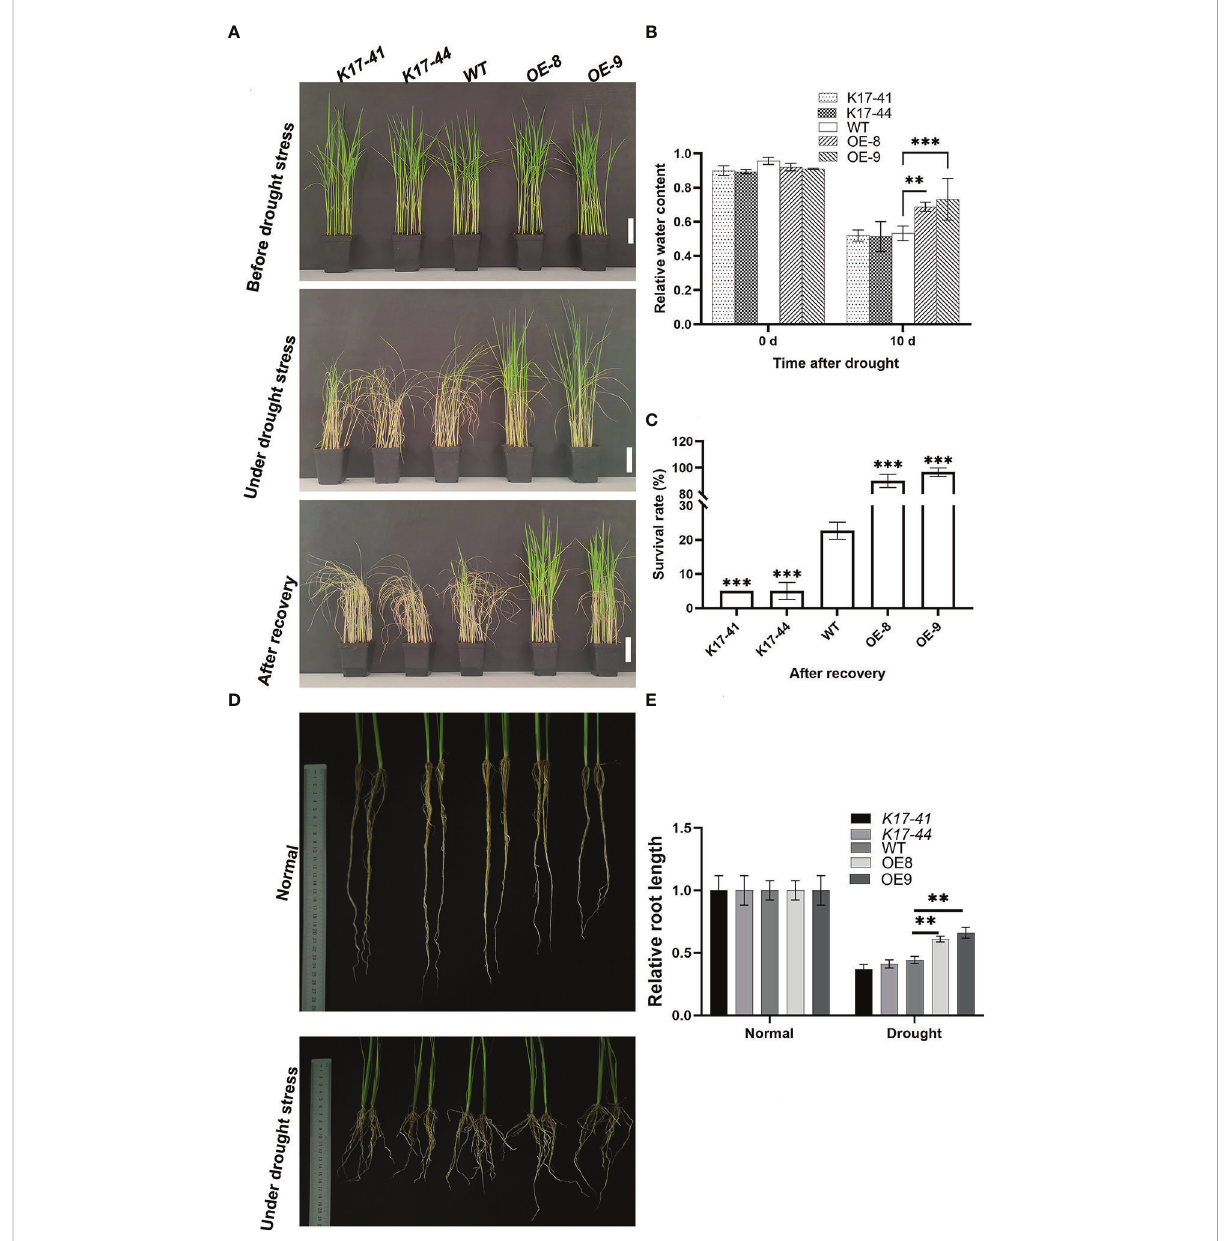
FIGURE 1 Drought tolerance was increased in OsCIPK17 -OE plants but decreased in OsCIPK17 -Mutant plants. (A) Growth phenotype of 3-week-old transgenic OsCIPK17 -OE, OsCIPK17 -Mutant, and WT plants at different stages of drought stress; bar = 7cm. The upper and middle channels in a have the same results as Gao et al. (2022a) (Published in the International Journal of Molecular Science on 18 October 2022). (B) Relative water content of drought- treated plants. Parameters of water status in 3-week-old OsCIPK17 -OE, OsCIPK17 -Mutant and WT plants were measured at 10 days after drought stress treatment (n=20). (C) Survival rates of each line after recovery were measured at 2 days after re-watering (n=60). (D) Growth phenotypes of 5-week-old transgenic OsCIPK17 -OE, OsCIPK17 -Mutant and WT plants under drought stress and normal water conditions. (E) Root length of each line in (D) was measured (n=6). Experiments in (A, D) were repeated three times, and similar results were obtained. Data in (B, C, E) , are presented as mean ± SD of three independent experiments, and the signi fi cant differences between OsCIPK17 -OE/ OsCIPK17 -Mutant and WT plants according to one-way ANOVA are indicated by asterisks. Asterisks indicate signi fi cance (**p < 0.01, ***p <